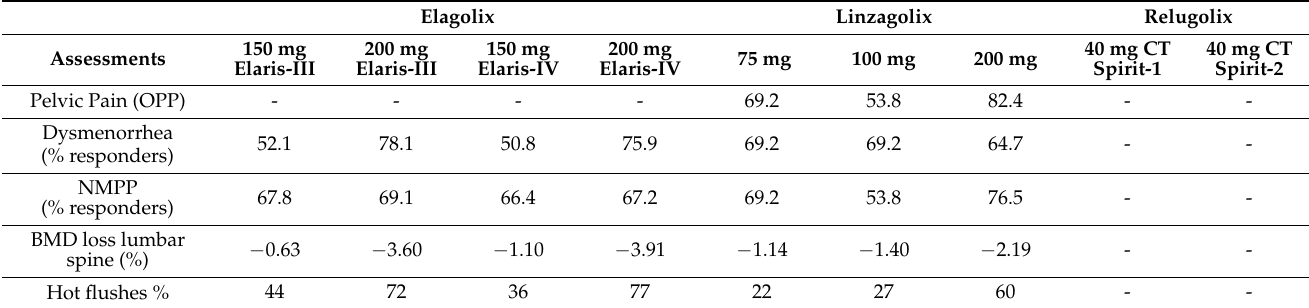
Figure 3. Mean percentage of bone mineral density (BMD) loss at week 24 (lumbar spine) in the different groups of women treated by different doses of GnRH antagonist (elagolix 150 mg once daily; elagolix 200 mg twice daily; linzagolix 75 mg, 100 mg and 200 mg once daily; and relugolix 40 mg combination therapy (CT): relugolix plus add-back therapy, once daily). Table 2. Efficacy and side effects of different doses of GnRH antagonist at 52 weeks